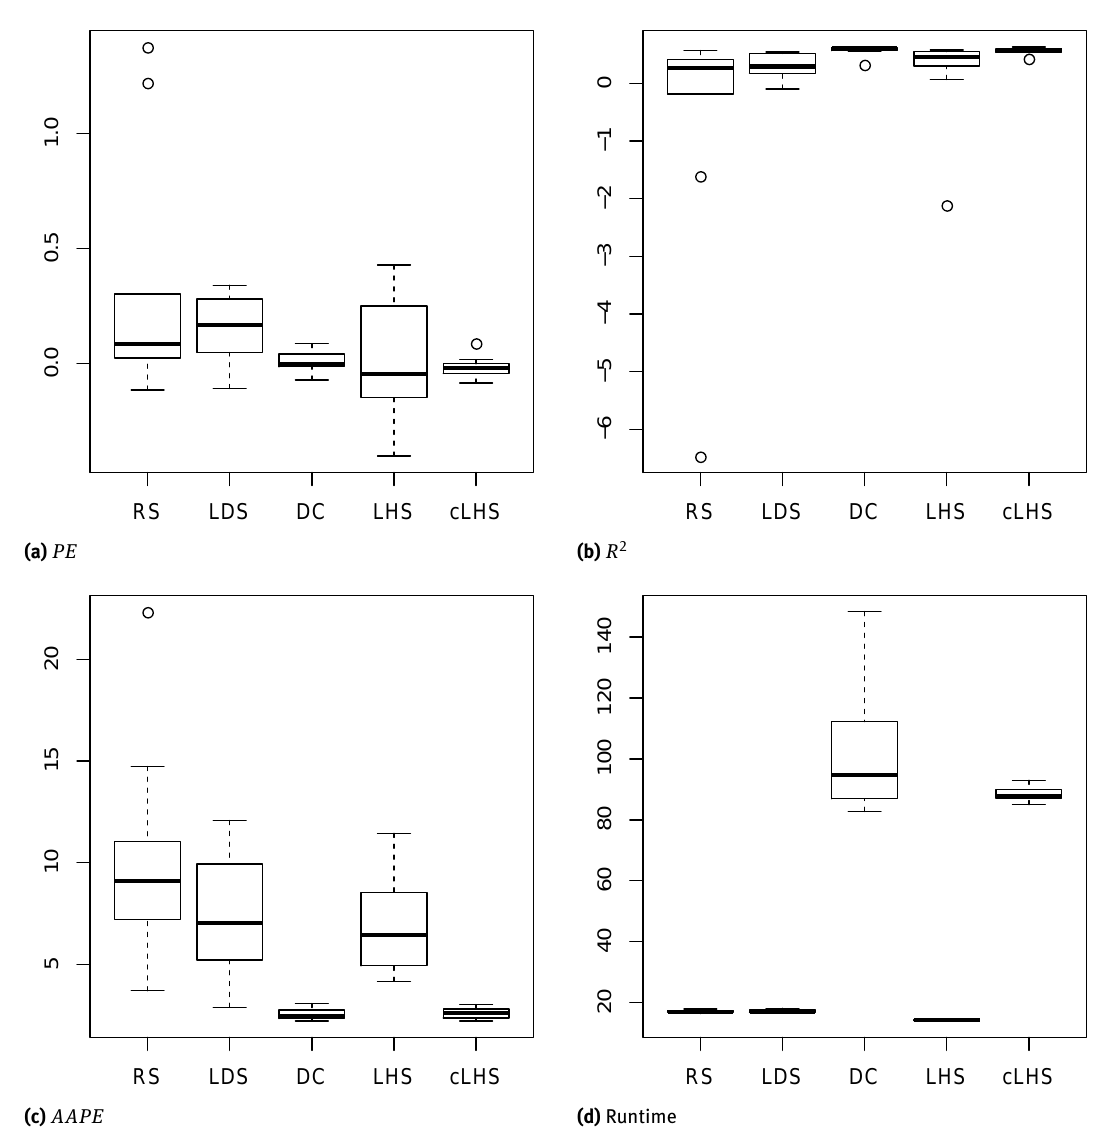
Figure 5: Box plots of the performance measures from 10 runs of the experimental design methods when s = 440